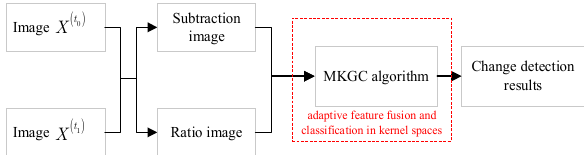
Figure 1. Proposed MKGC change detection method.